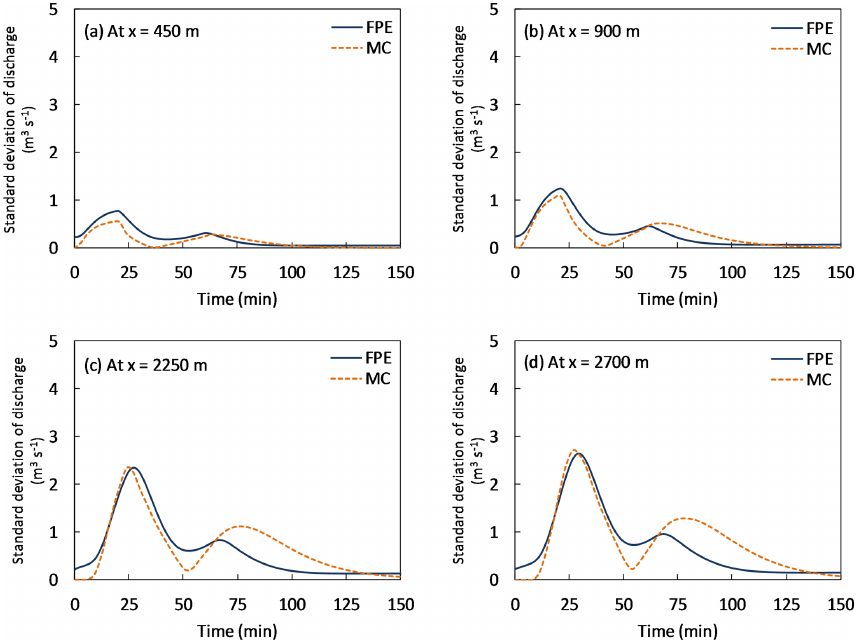
Figure 10. Comparison of the standard deviation of the flow discharge obtained by the FPE methodology and the MC approach as a function of time, at different channel